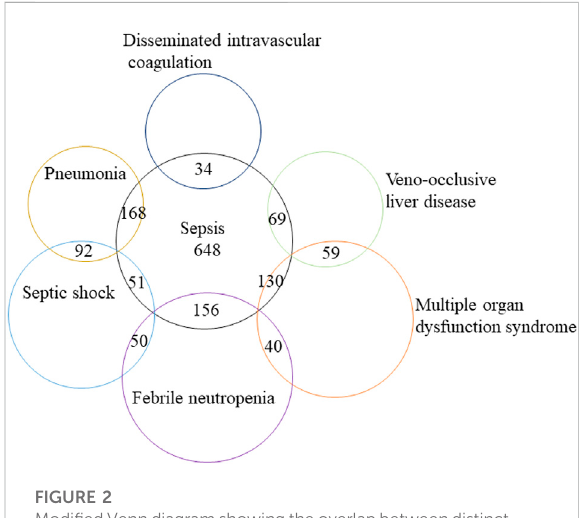
FIGURE 2 Modi fi edVenndiagramshowingtheoverlapbetweendistinct classes of sepsis-related toxicities and other lethal AEs, such as veno-occlusive liver disease. AEs, adverse events.